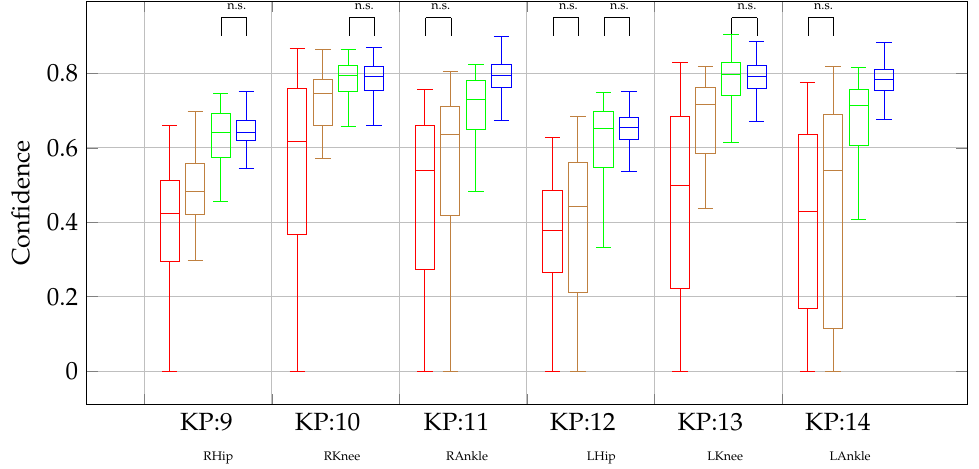
Figure 5. Confidence of detection of selected KP (keypoints)—front view, lower body. Camera views are shown in colour as follows: lying down ( N = 75), on the knees ( N = 26), sitting ( N = 186) and standing ( N = 70). All the other differences are statistically significant. Only differences that were not statistically significant (n.s.) are highlighted in the boxplots.